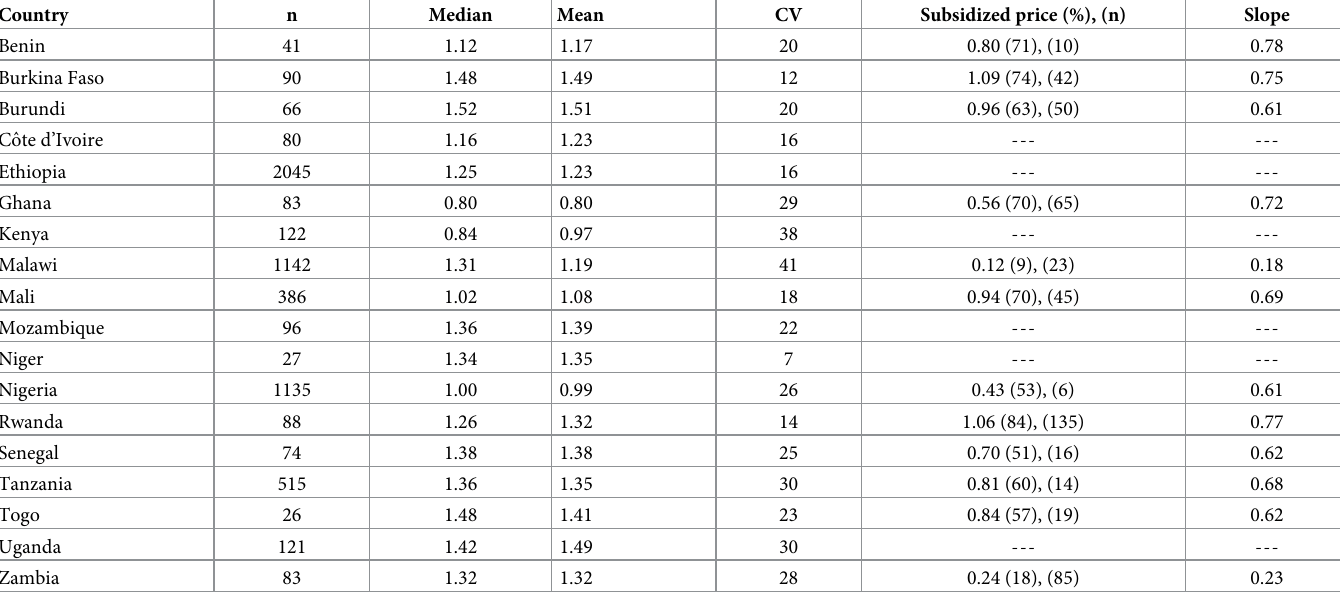
Table 2. Number of observations, median, mean price, and coefficient of variation (CV) for non-subsidized urea price (USD kg -1 ) per country. Subsidized urea price (median-USD kg -1 ), percentage of the non-subsidized urea price, and number of observations per country (values between parenthesis). Slope (USD kg -1 ) of the regression models between subsidized and non-subsidized